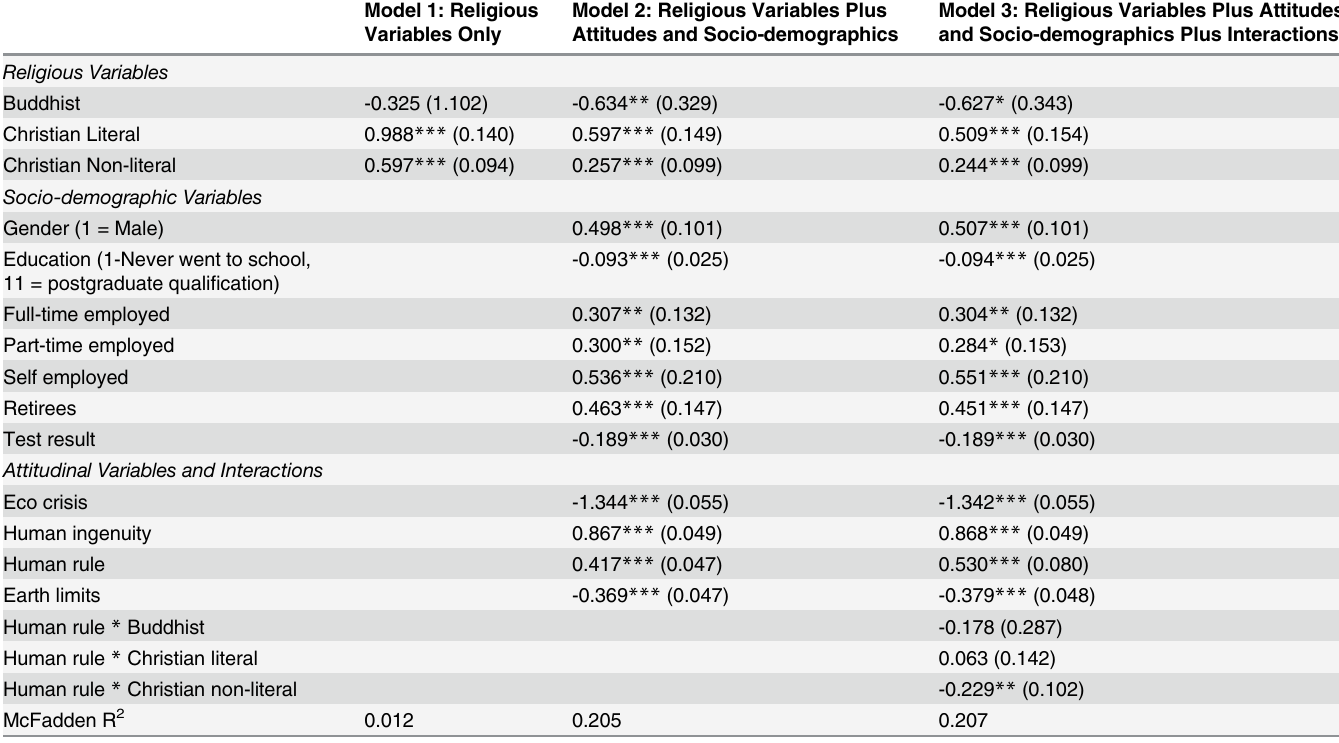
Table 6. Ordinal regressions showing the effect of religious variables, attitudes and socio-demographics on climate change segment membership. Model 1: Religious Model 2: Religious Variables Plus Variables Only Attitudes and